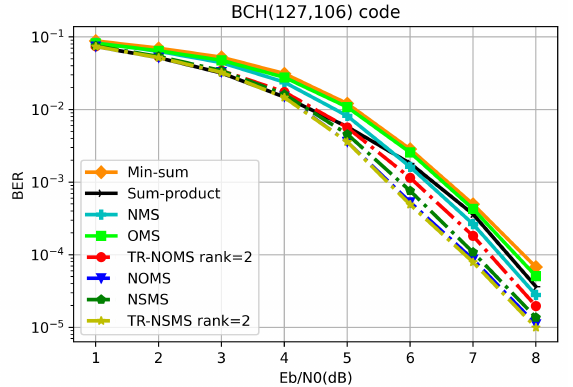
Figure 9. BER performance of TR-NOMS, TR-NSMS, NOMS [22] and NSMS algorithms for BCH(127,106)